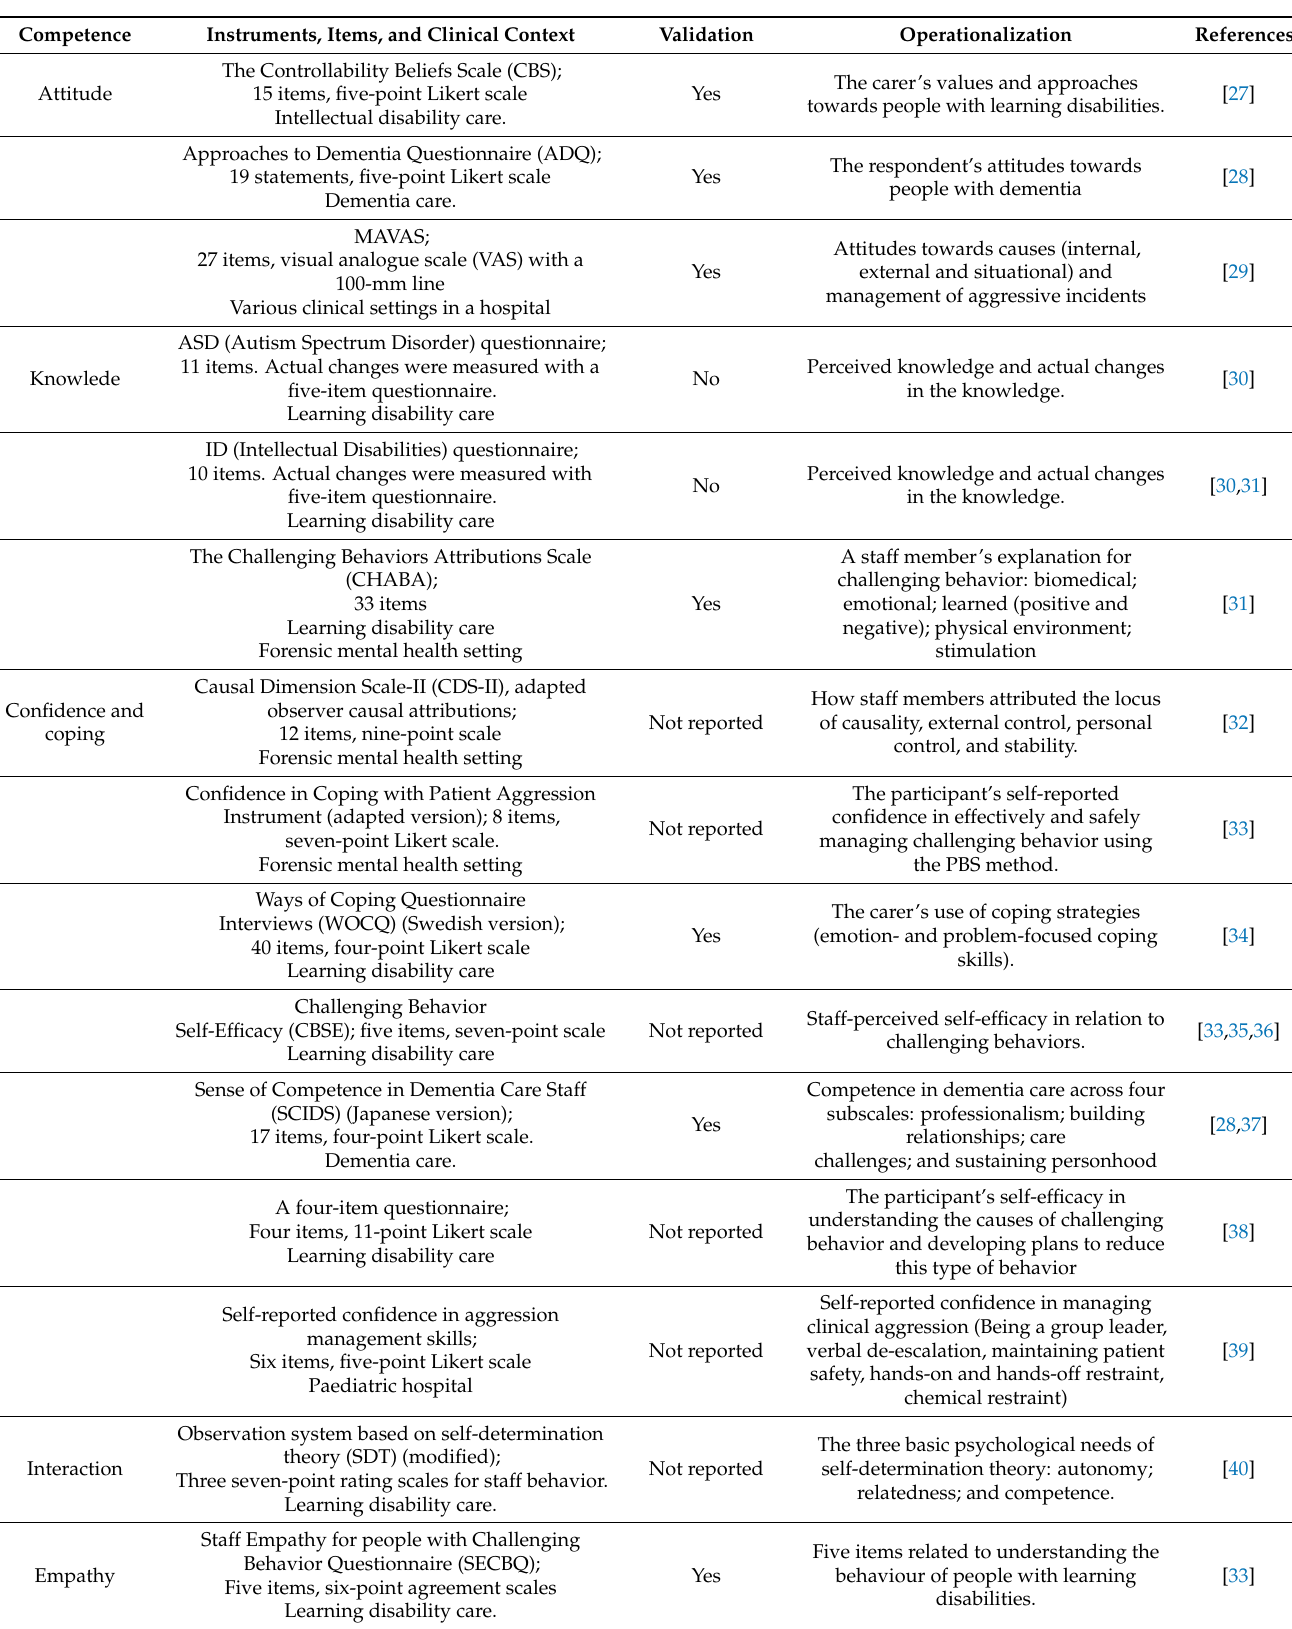
Table 1. Instruments used between 2016–2021 to measure competence in managing challenging